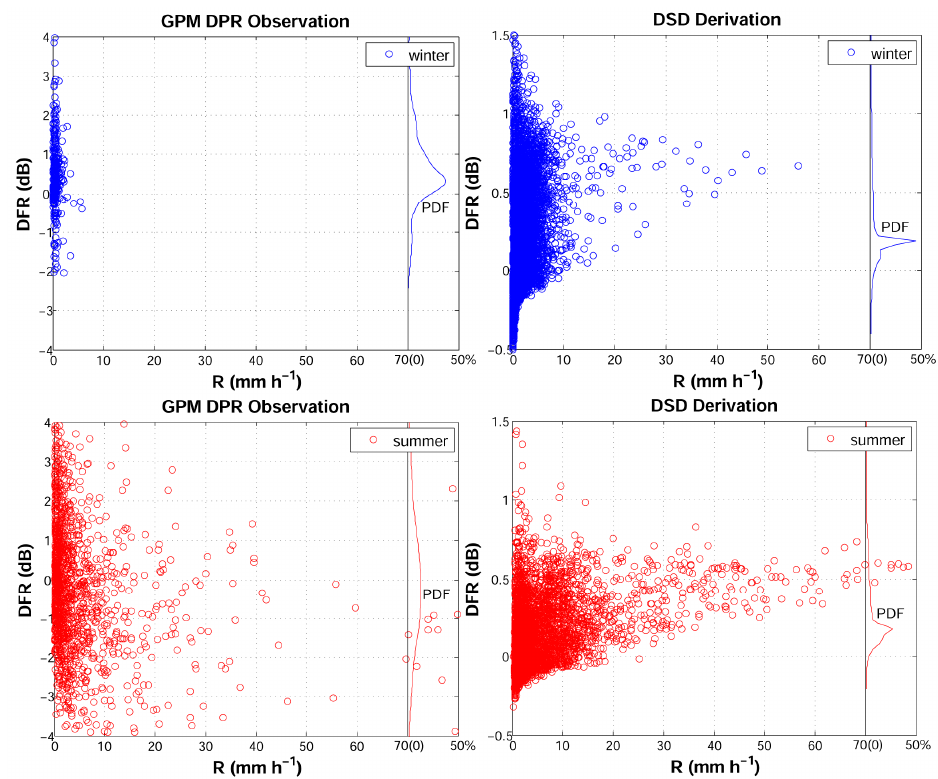
Figure 3. Scatterplots of the dual-frequency ratio (DFR) versus rain rate from DPR observations and raindrop size distribution (DSD) derivations on the same scale during winter (blue circles) and summer (red circles) over Jianghuai region. The left two panels represent results from GPM observations, and the right two panels represent results from DSD derivations. The probability density functions (PDF) of the DFR are also given in each panel.